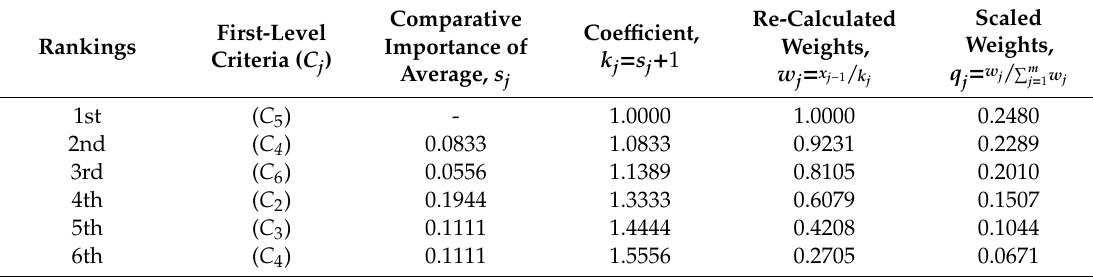
Table 3. Estimated weights for DM 1 based on the stepwise weight analysis ratio assessment (SWARA) weighting method.